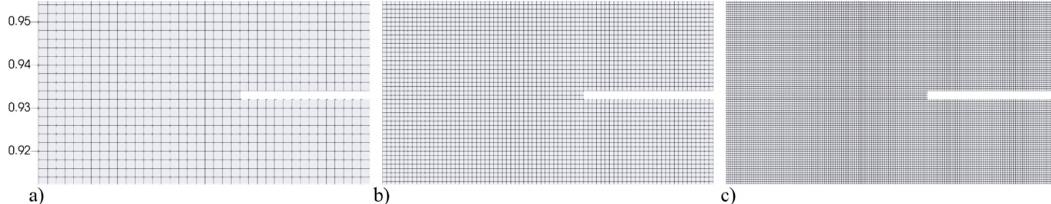
Figure 2. Part of the grid ( a ) mesh No. 1, ( b ) mesh No. 2, ( c ) mesh No. 3.